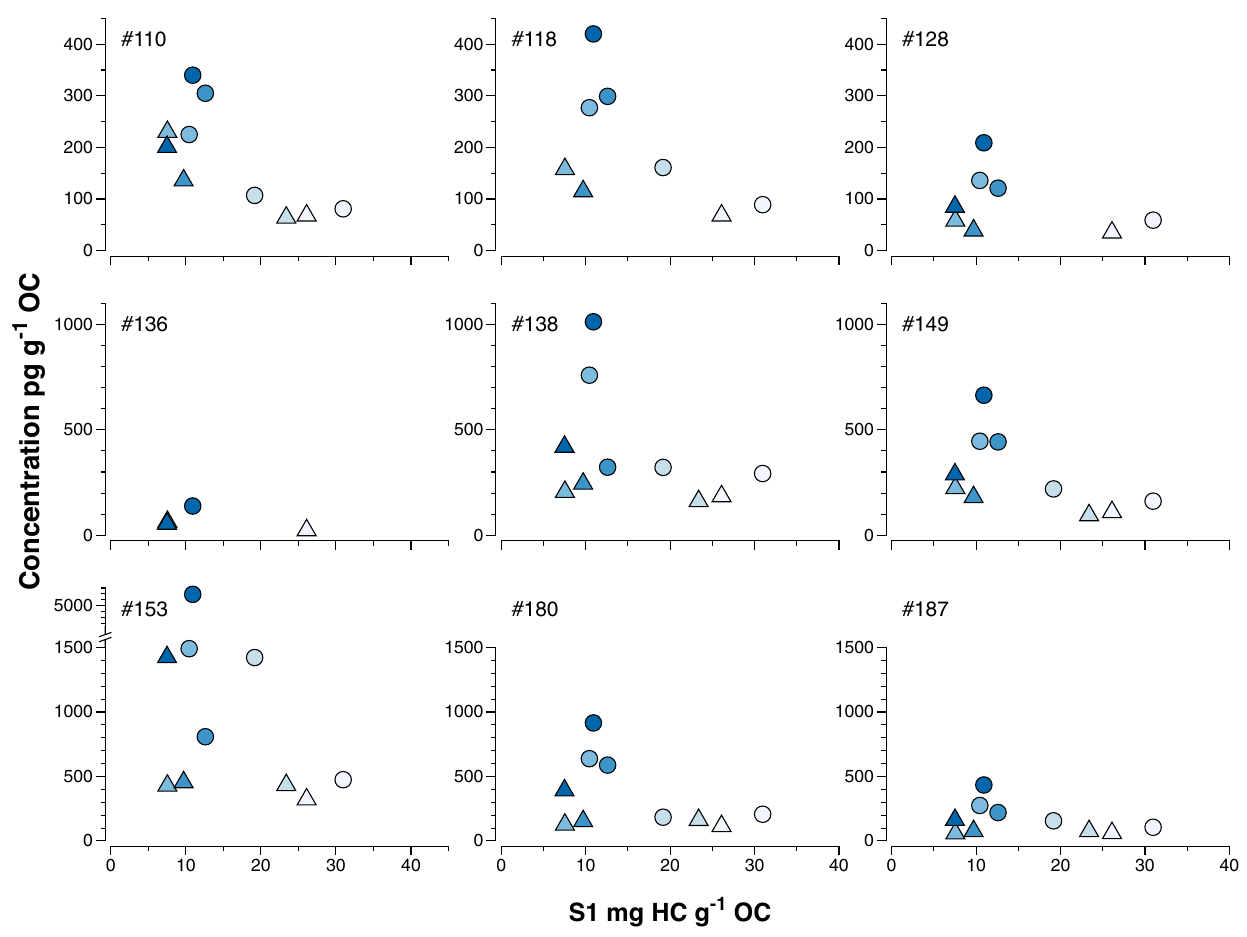
Fig. 6 | Inverse relationship between concentrations of nine polychlorinated biphenyl (PCB) congeners inpgg − 1 organic carbon(OC) and those ofthe labile protohydrocarbons (HC) (S1 mg HC g − 1 OC) in the Atacama surface sediment